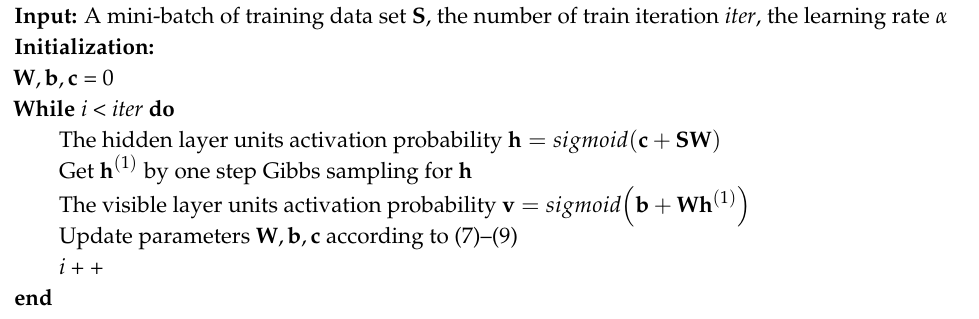
Algorithm 1: Pre-training of standard RBM